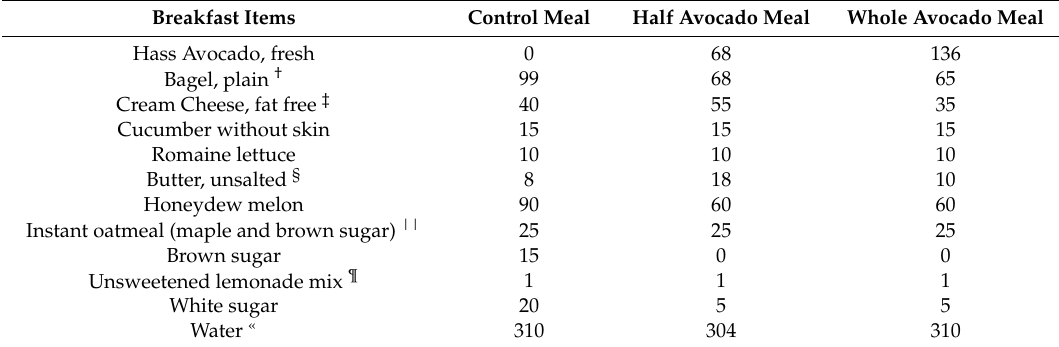
Table 2. Breakfast meal foods (grams, g) for postprandial study visits